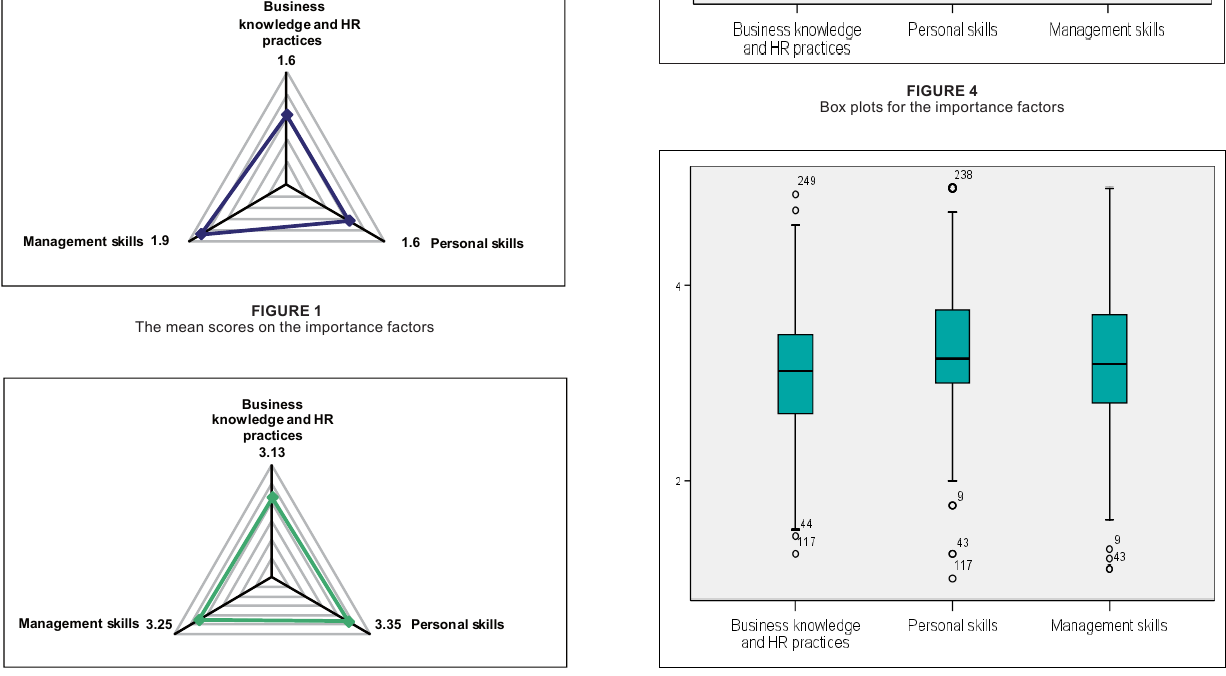
FiguRE 2 The mean scores on the satisfaction factors